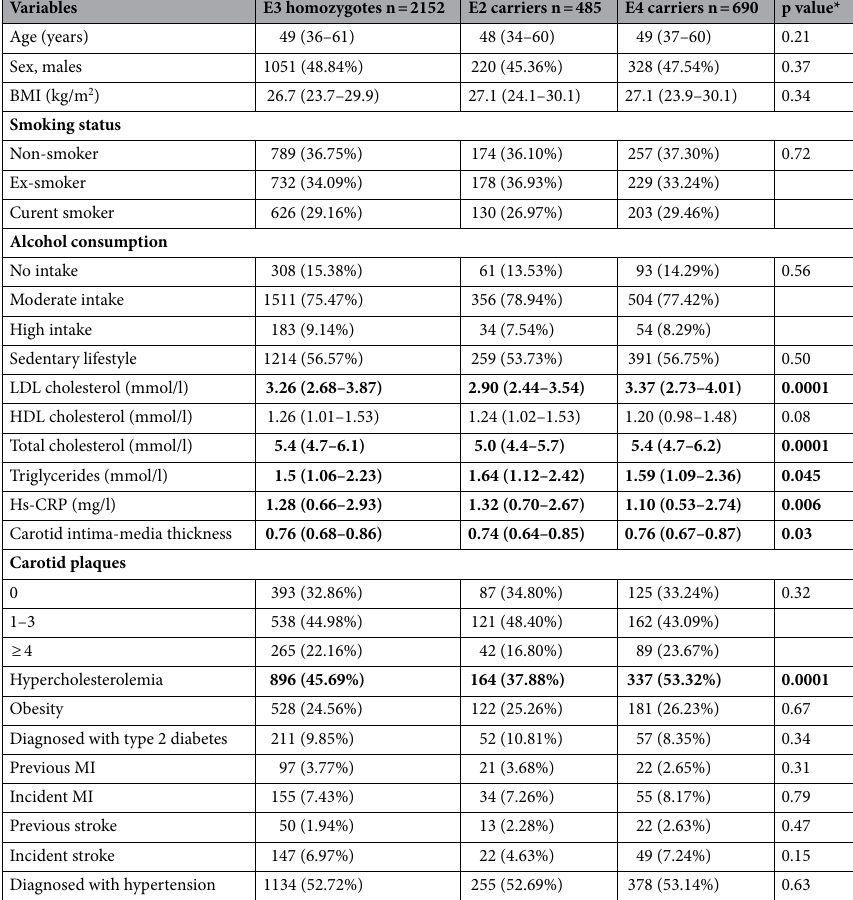
Table 1. Characteristics of the study population at baseline stratified by APOE carrier status (n =